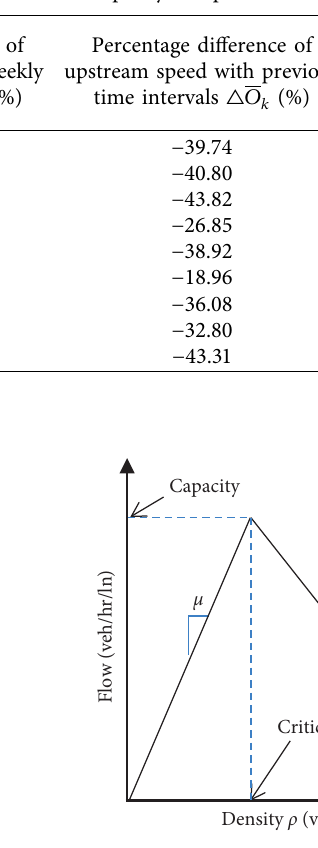
Table 2: Speed and occupancy comparison with weekly and previous time interval